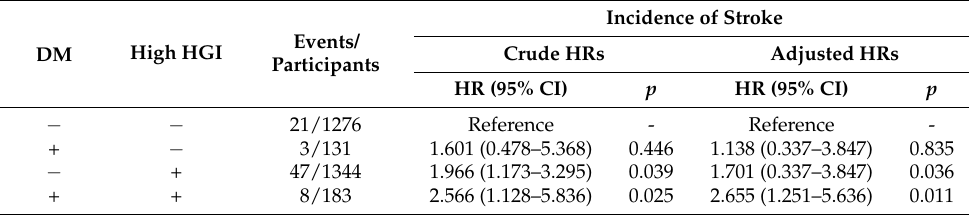
Figure 4. The RCS of HGI levels and incident stroke risk grouped by DM status. The HGI had a linear correlation with the risk of onset stroke, in which higher HGI could increase the risk of inci- dent stroke. Meanwhile, even in the subjects without DM, high HGI still could increase the risk of incident stroke. ( A ). The RCS of HGI and risk of incident stroke in non-DM participants, n = 2620; ( B ). The RCS of HGI and risk of incident stroke in DM participants, n = 314. Abbreviations: HR, hazard ratio; CI, confidence interval; HGI, glycated hemoglobin index.